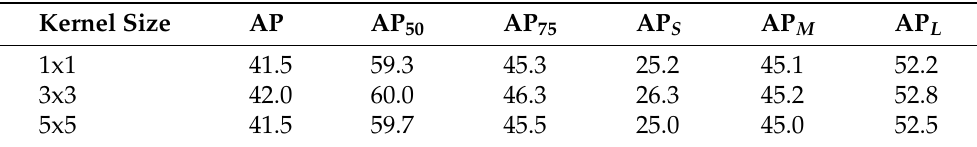
Table 10. Results of different kernel sizes of the 3D max pooling operation in the second max pooling stream of DeMF on COCO val2017